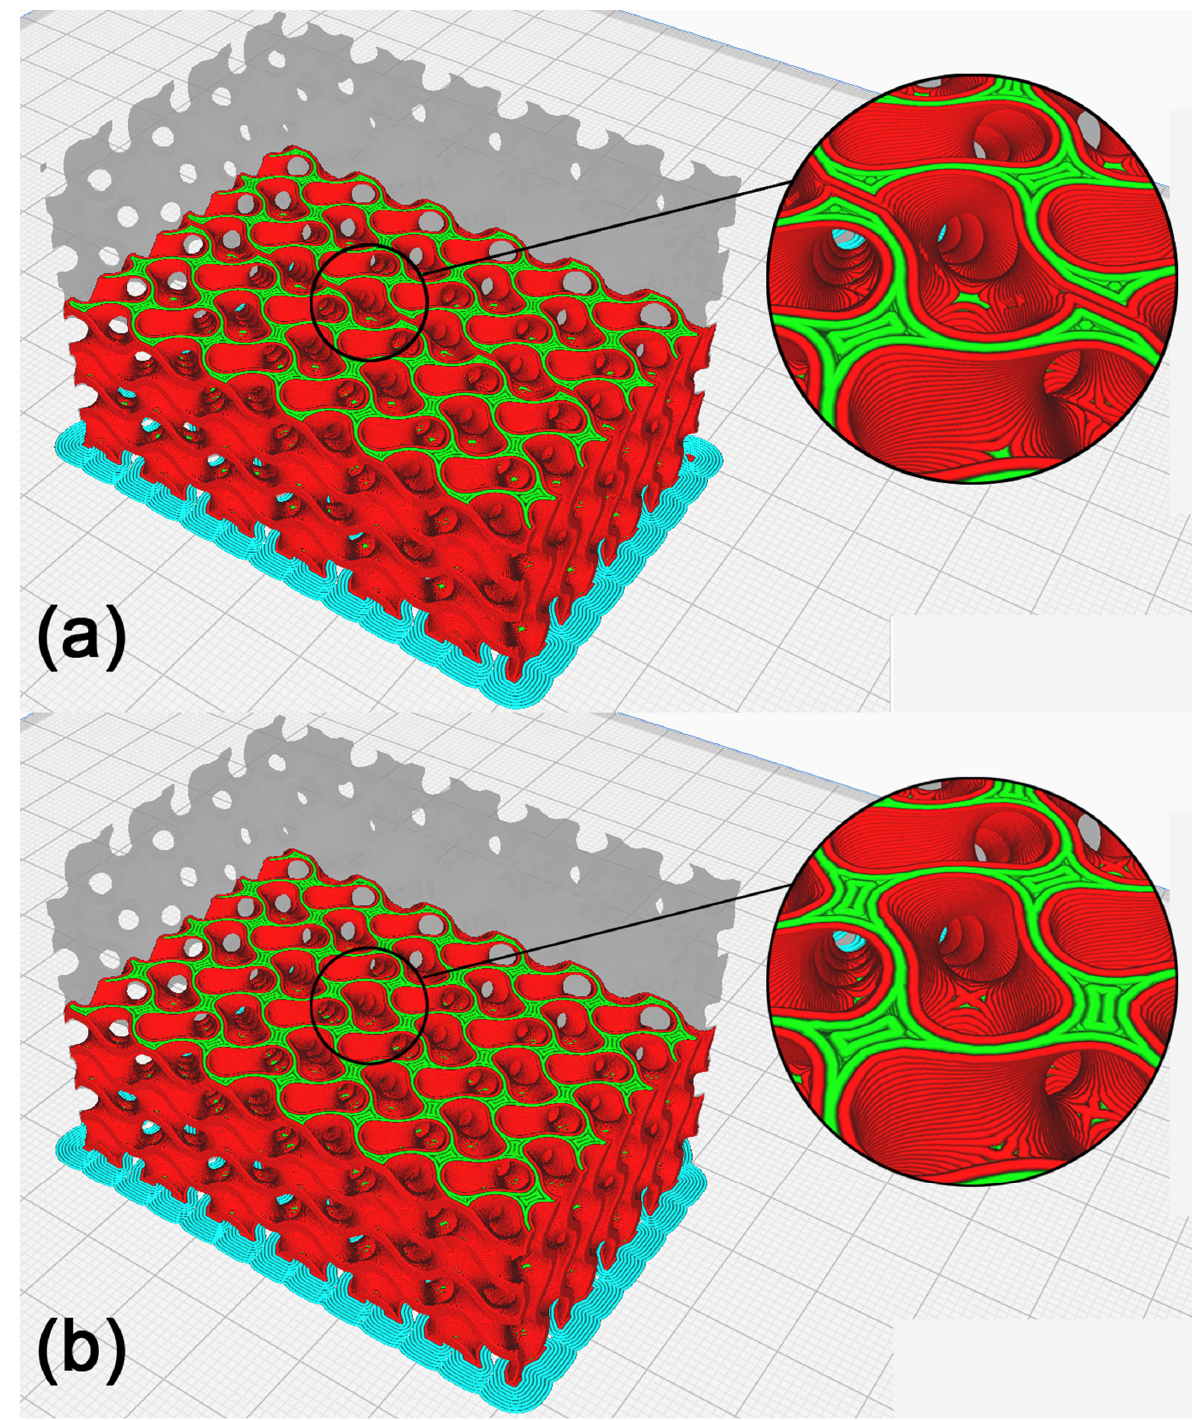
Figure 12. Cellular structure model comparison. ( a ) Illustration of the toolpath process of production before applying the repair method; ( b ) illustration of the toolpath process after repair.